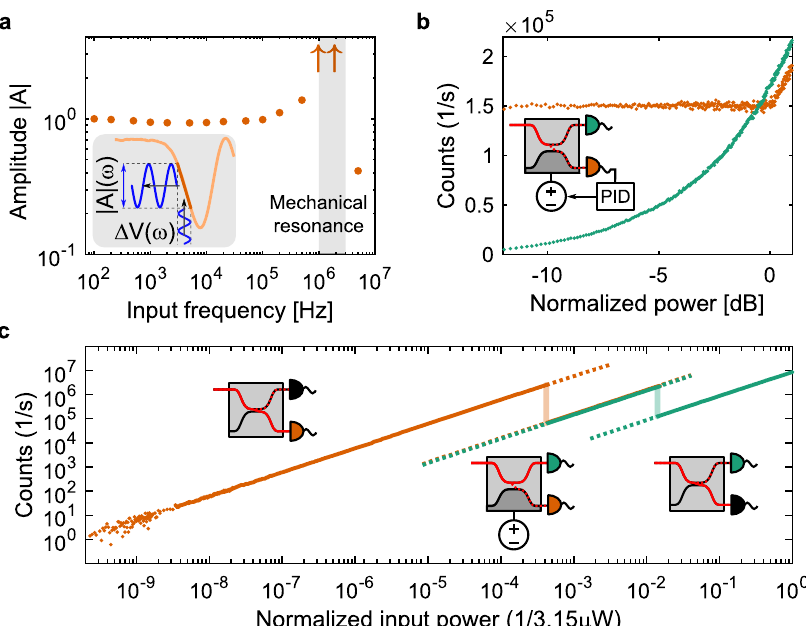
Fig. 2 Frequency response and demonstrated applications. a Frequency response of the tunable beam splitter measured using an on-chip detector up to the fi rst resonance frequency normalized to the DC amplitude. The arrows represent the low bound of those measured amplitudes. Inset: this measurement was performed by translating the actuation voltage into a modulation of the splitting ratio. b PID-controlled power stabilization on one arm (detector A, orange) using the on-chip detectors and the MEMS-tunable beam splitter. The other arm (detector B, green) detects the rerouted power. The detection events are counted by the driving electronics of the detectors. c 90 dB dynamic range on-chip photodetector that combines a high and a low- ef fi ciency detector with switchable measurement ranges. The vertical connections are the measured counts while changing the MEMS voltage from 0 V to 196.5 V. The insets show the active detectors and MEMS settings in each of the three ranges: for lowest input power, Detector A is used with most of the power routed to its waveguide. For medium input powers the MEMS splitter routes most of the optical power to lower-ef fi ciency Detector B, and both detectors can be used. For highest optical power, no actuation is applied and low-ef fi ciency Detector B is